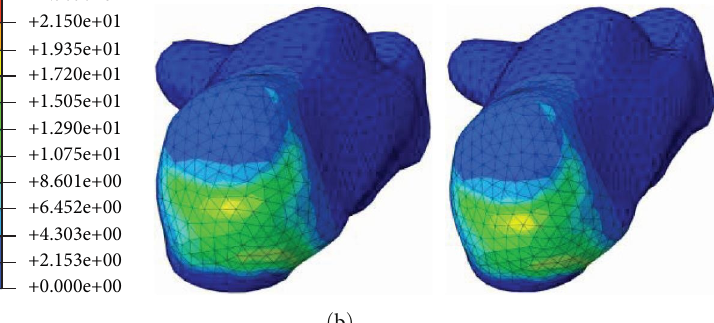
F IGURE 9: Calcaneus stress distribution (a) at t 1 , t 2 , and t 3 gait instants in RFS jogging (from left to right) and (b) at t 2 and t 3 gait instants in FFS jogging (from left to